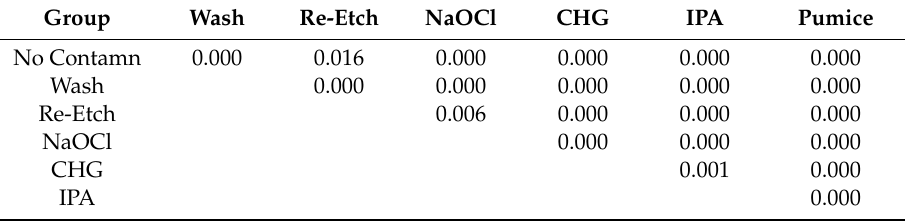
Table 4. Mann–Whitney post-hoc comparison between the SBS recorded in total-etch groups.